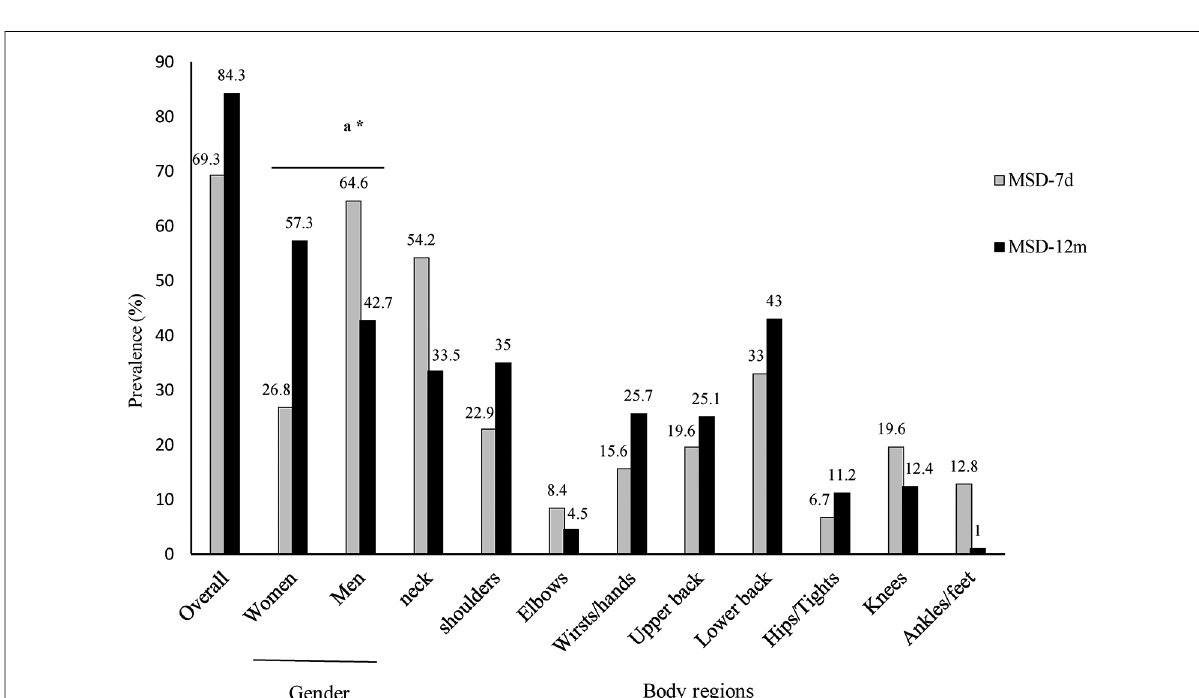
FIGURE 2 Prevalence of MSDs in body regions and gender.MSD-7d: MSD during the last 7 days; MSD-12m: MSDs during the last 12 months, a: gender comparison of MSD-12 m between males and females ; *: p